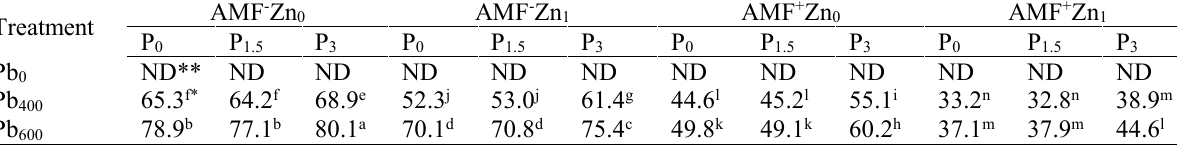
Table 5. Effects of Zn oxide nanoparticles, Pb, and AMF on plant Pb concentration (mg/kg) Treatment